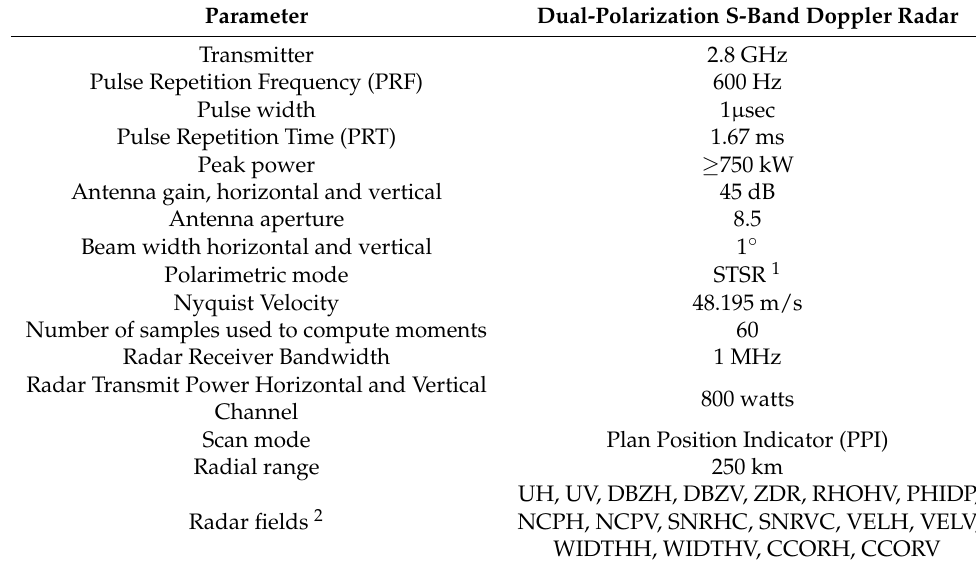
WIDTHH, WIDTHV, CCORH,